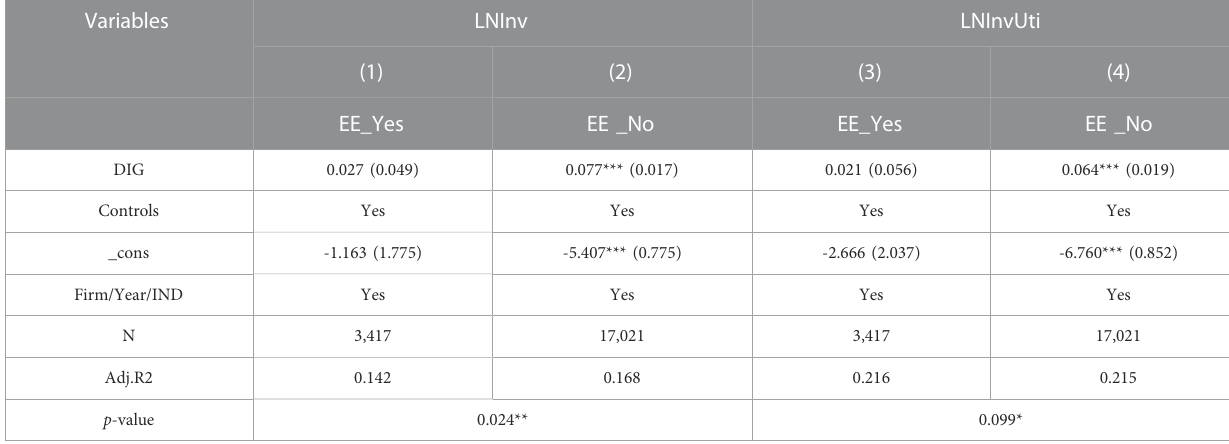
TABLE 13 Heterogeneity test based on ecological expenditures. Variables